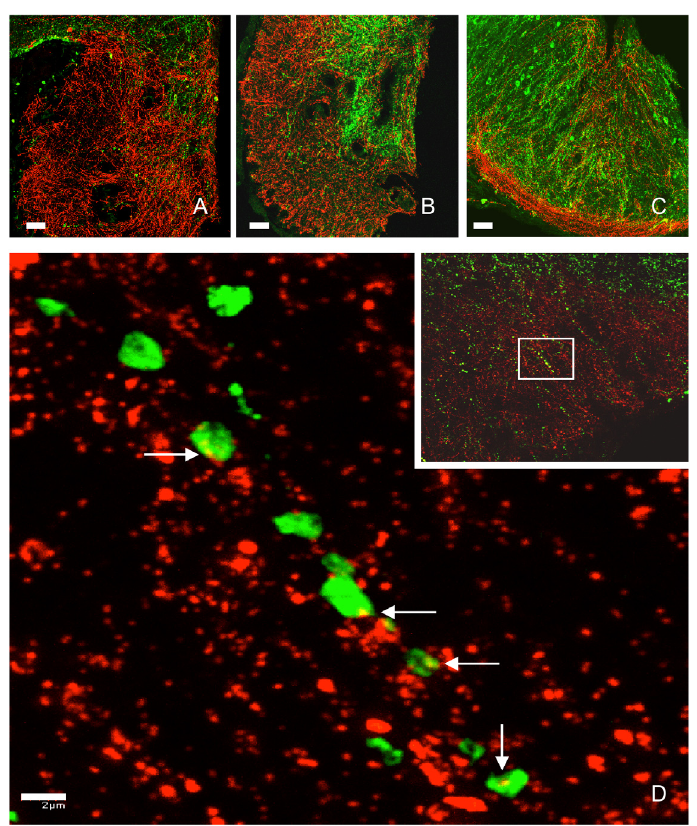
Figure 3. Kisspeptin projections to the median eminence intermingle intimately with GnRH fibers in the monkey. Interactions between kisspeptin (green fluorescence) and GnRH (red fluorescence) fibers in hemi-coronal sections at the anterior ( A ), mid-tuberal ( B ), and posterior ( C ) aspects of the median eminence of a castrated adult male rhesus monkey. Note, in panel B , the heavy kisspeptin innervation of the internal zone of the median eminence and GnRH innervation of both the internal and external zones. Panel D shows high-power magnification of kisspeptin axonal beads in contact with GnRH fibers (white arrows) in the external zone of the median eminence shown in the inset. GnRH, gonadotropin-releasing hormone. Reproduced from Ramaswamy et al . 44 with permission of the Endocrine Society.